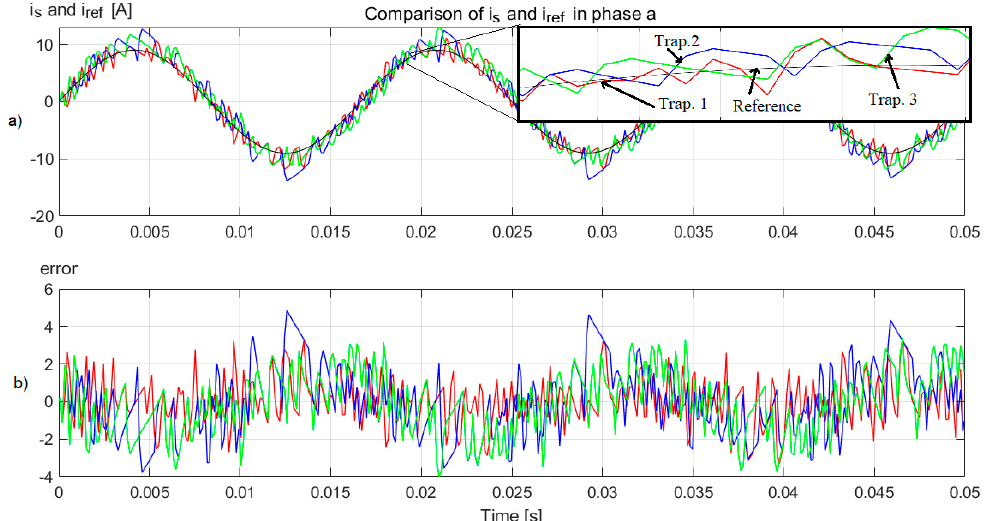
Figure 12. Comparison of i s and i ref in phase a for compound trapezoidal methods with sampling period modified ( a ) Reference source current waveform, i ref , and measured current waveform, i s , in phase a using first-, second-. and third-order trapezoidal approximations, for Ts = 100 µ s; ( b ) error magnitude.